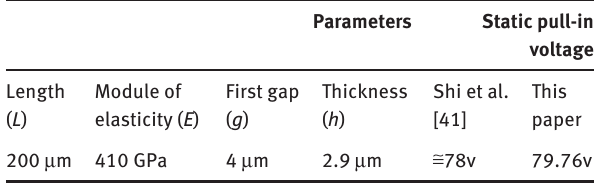
Table 3 Comparing the static pull-in voltage for an FGM microgrip- = 0% with the one reported in reference [41]. per with the case of V c